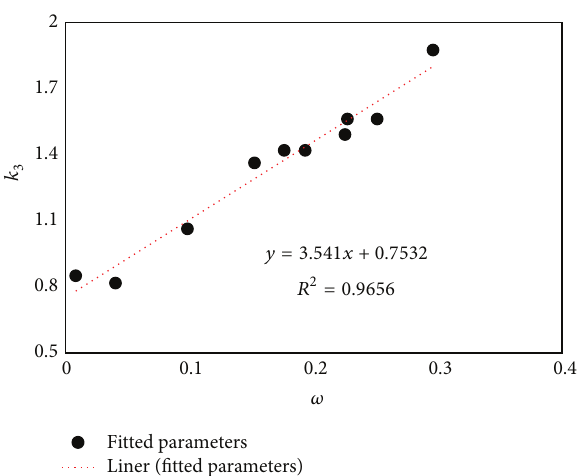
Figure 3: Linear trend of fitted parameter 𝑘 3 of the 𝛼 -function equation